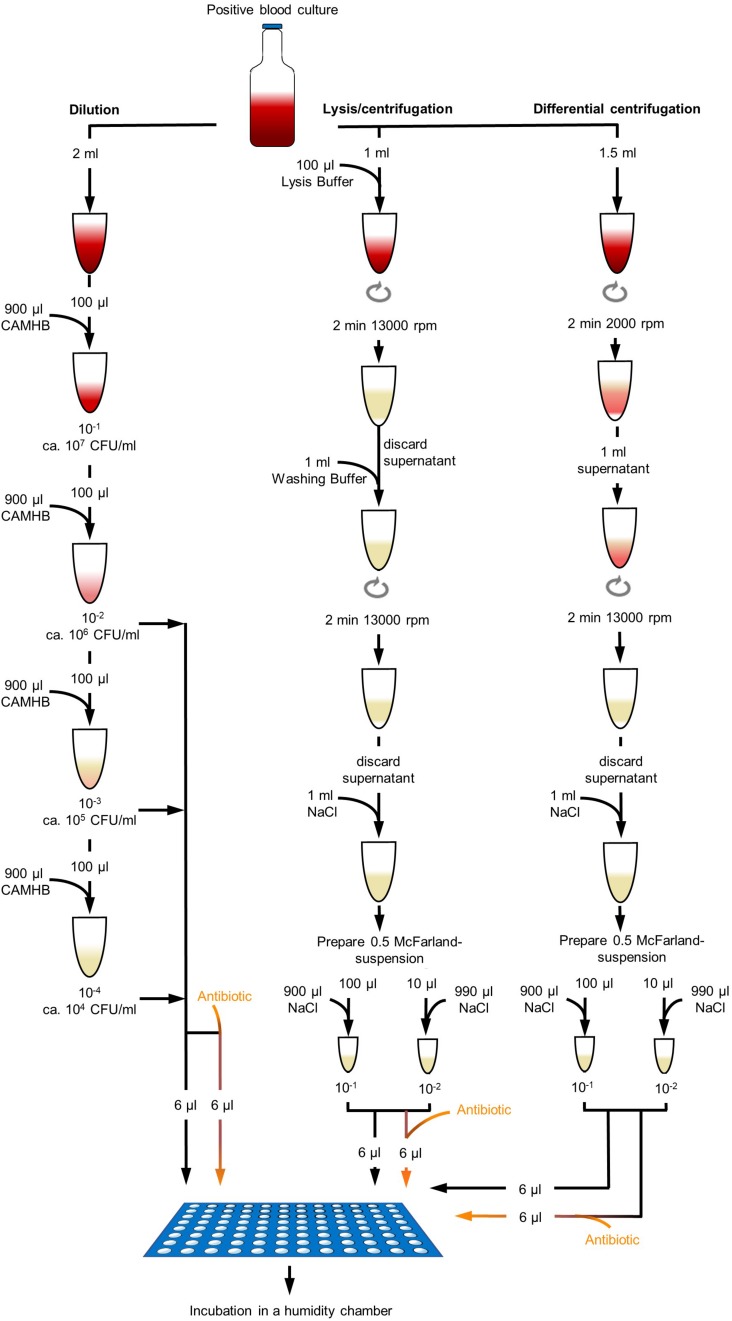
Different processing methods of positive blood culture broth. Dilution method was done with dilution steps up to 10– 4 in CAMHB. Dilutions were directly used for DOT-MGA. Lysis/centrifugation method was done according to the protocol of MBT Sepsityper kit (Bruker Daltonik GmbH, Bremen, Germany; version prior to introduction of rapid workflow and improved formulation), but only 100 μl lysis buffer was used. Differential centrifugation was performed with a first centrifugation step of 2 min at 2000 rpm and a second centrifugation step of 2 min at 13,000 rpm. Obtained pellets were resuspended and a standardized 0.5 McFarland suspension was prepared. Two different dilutions were used for DOT-MGA.